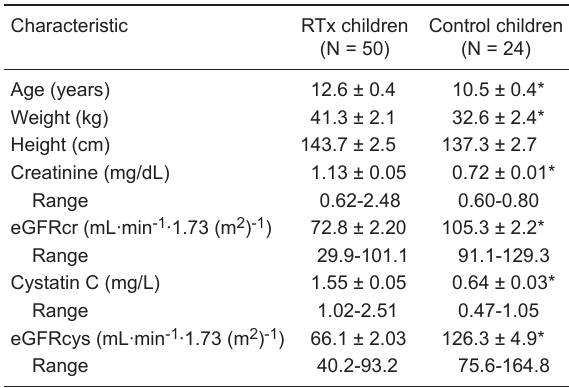
Table 2. Renal function tests in the study